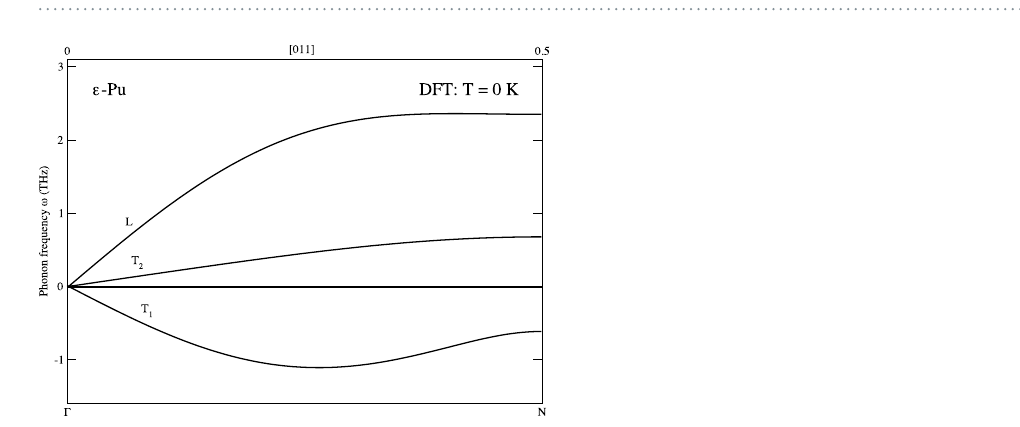
Figure 3. Calculated DFT (T = 900 K) phonons for ε -plutonium (full line) at the atomic volume 24.6 Å 3 and DMFT results 6 (dashed line).